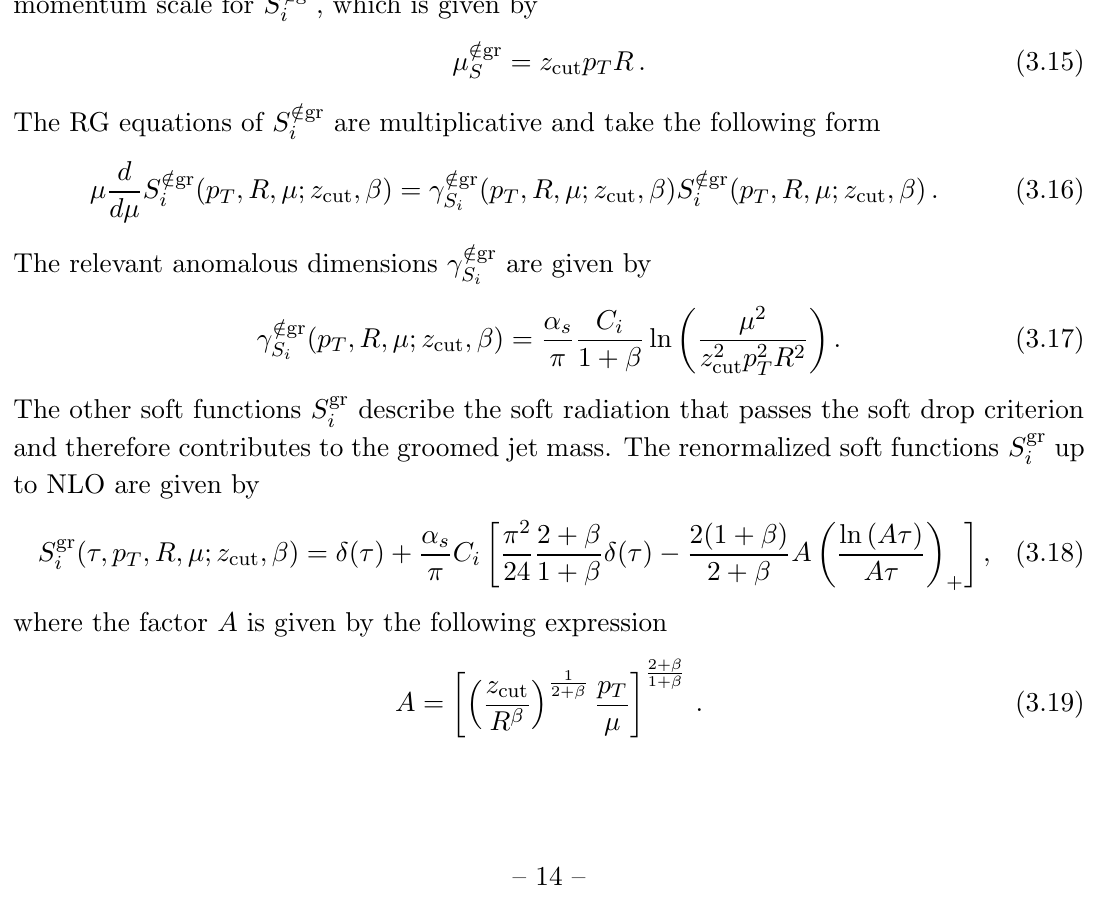
. The second step is a soft collinear factorization of ab , collinear functions C i as well as two soft functions S = 2 gr H c ! i